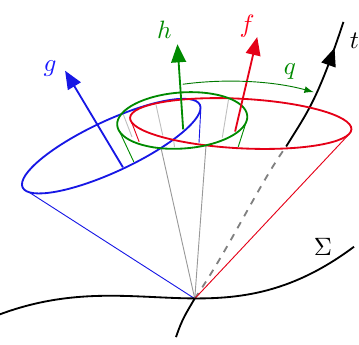
Figure 1 . The null cones of the metrics g , f , and the geometric mean metric h . The shift vector of h is denoted as q and given relative to a common time coordinate t